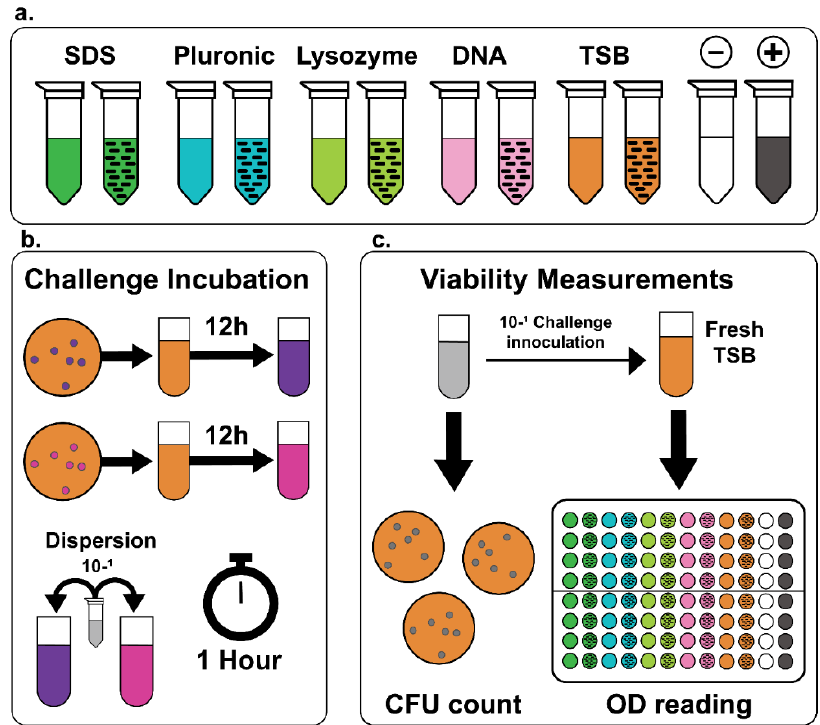
Figure 1. Experimental design of the SWNT antimicrobial challenges. ( a ) Dispersions used in the experiment. Cultures were challenged against the dispersant and the dispersant with SWNTs. ( b ) Challenge incubation. Overnight growth cultures of Salmonella and Staph aureus were diluted in fresh TSB to OD 600 = 0.5 and incubated with the challenging solution for one hour. ( c ) The challenge incubations were platted for CFU counting and inoculated into fresh TSB for growth curve construc- tion.